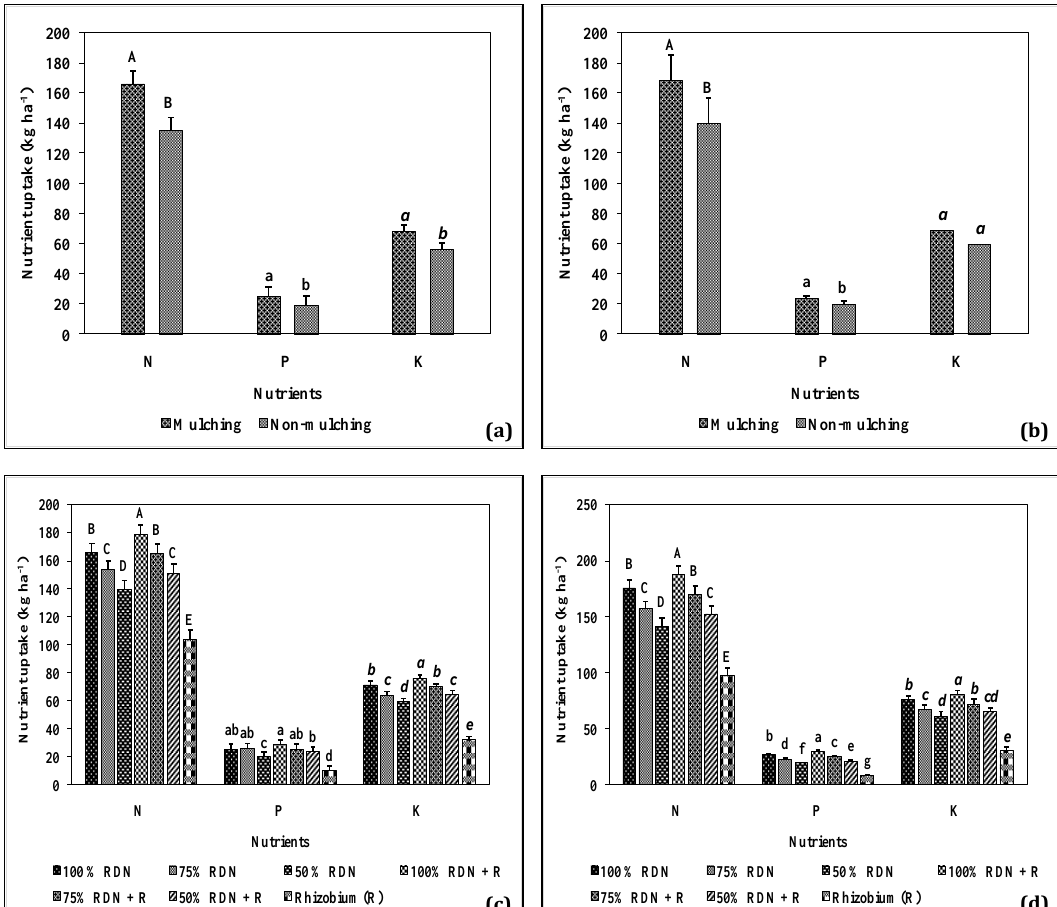
Figure 6. Effect of soil mulch ( a , b ) and nutrient management ( c , d ) on peanut total nutrient uptake at different growth stages (data from 2015–2016 and 2016–2017 crop seasons, respectively). DAE—days after emergence; error bars represent the least significant difference values. Di ff erent letters on the bars indicate significant di ff